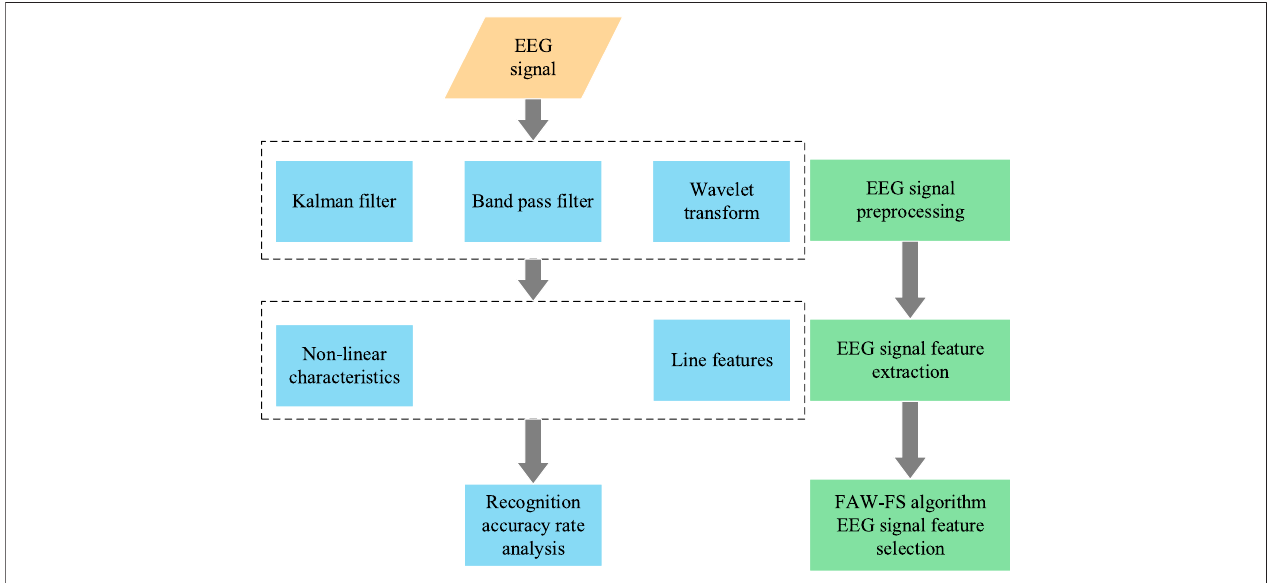
FIGURE 2 | Flow chart of depression recognition based on meta heuristic algorithm.